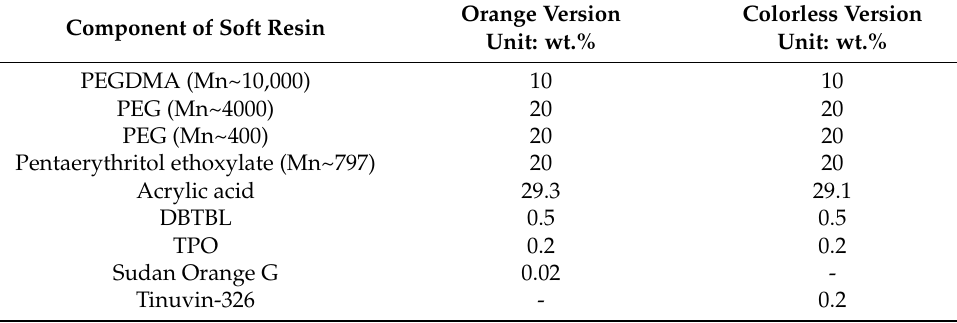
Table 1. Resin formulations for the soft material. Component of Soft Resin